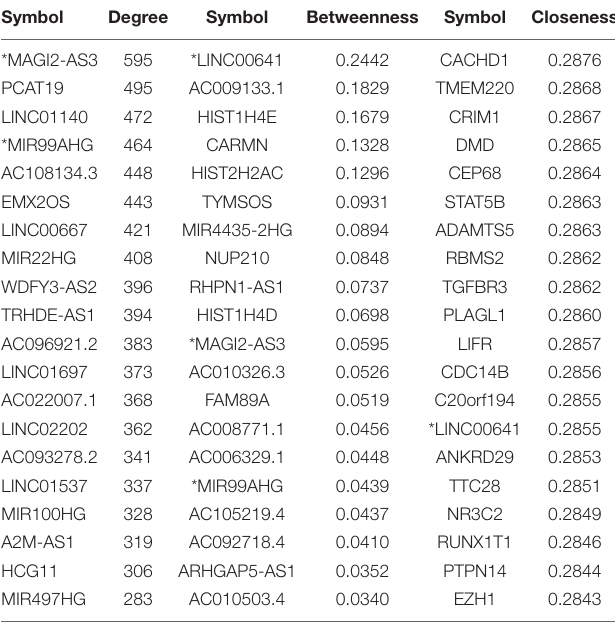
TABLE 1 | The top 20 lncRNAs/PCGs in degree, betweenness, and closeness. Symbol